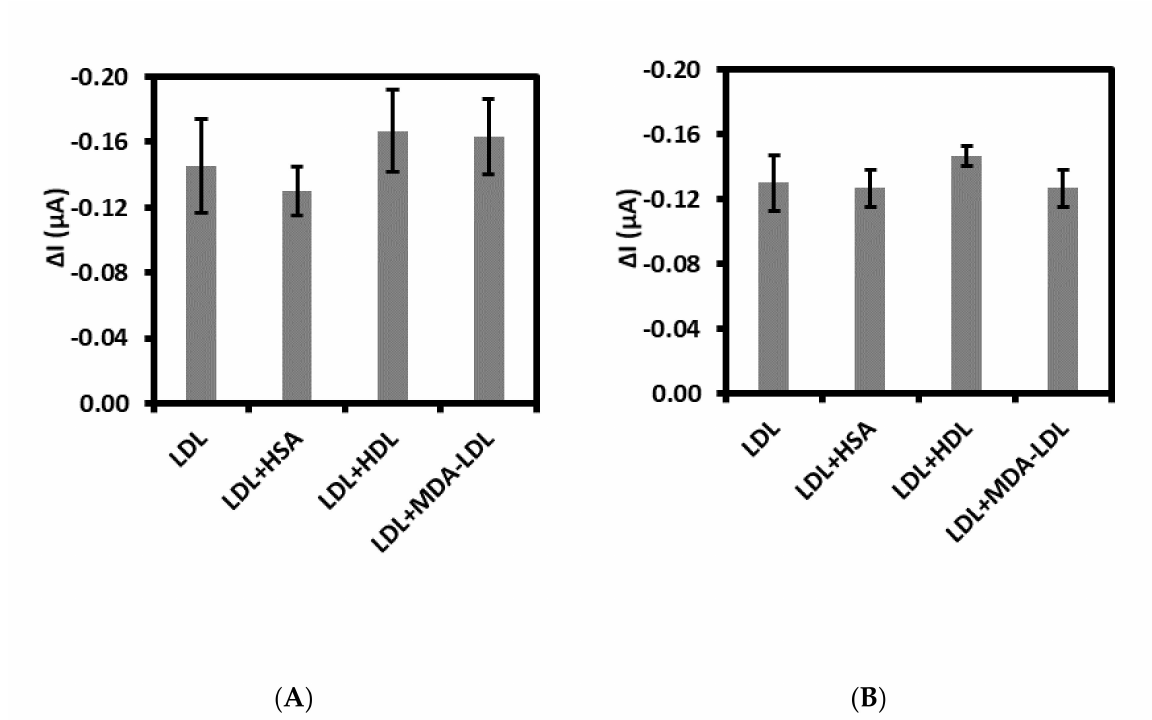
Figure 5. Selectivity of ( A ) immunosensor and ( B ) aptasensor with 0.01 ng/mL LDL along with different interferents: HSA, HDL, and MDA-LDL at 0.5 ng/mL concentration